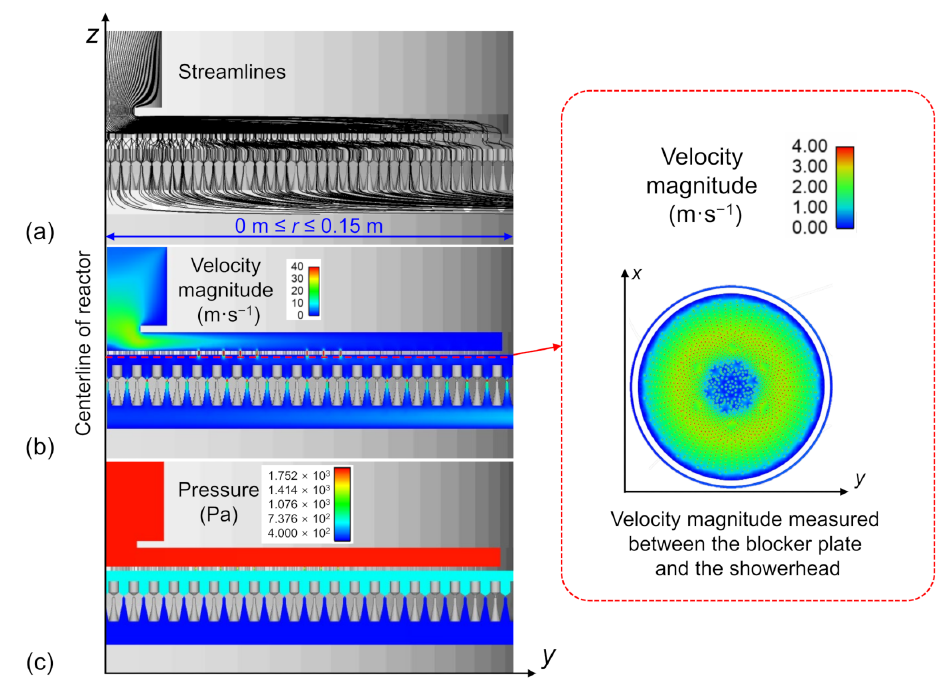
Figure 3. Results of the 3D gas flow simulation for Case 3 ( r p = 2.0 × 10 − 6 m, d = 9 mm): ( a ) streamlines; contour plots of the ( b ) gas velocity and ( c ) gas pressure. It is observed that the streamlines of the interim · space between the blocker plate and showerhead are most curled at the center of the reactor ( r ≤ 50 mm) owing to the effect of the high Reynolds